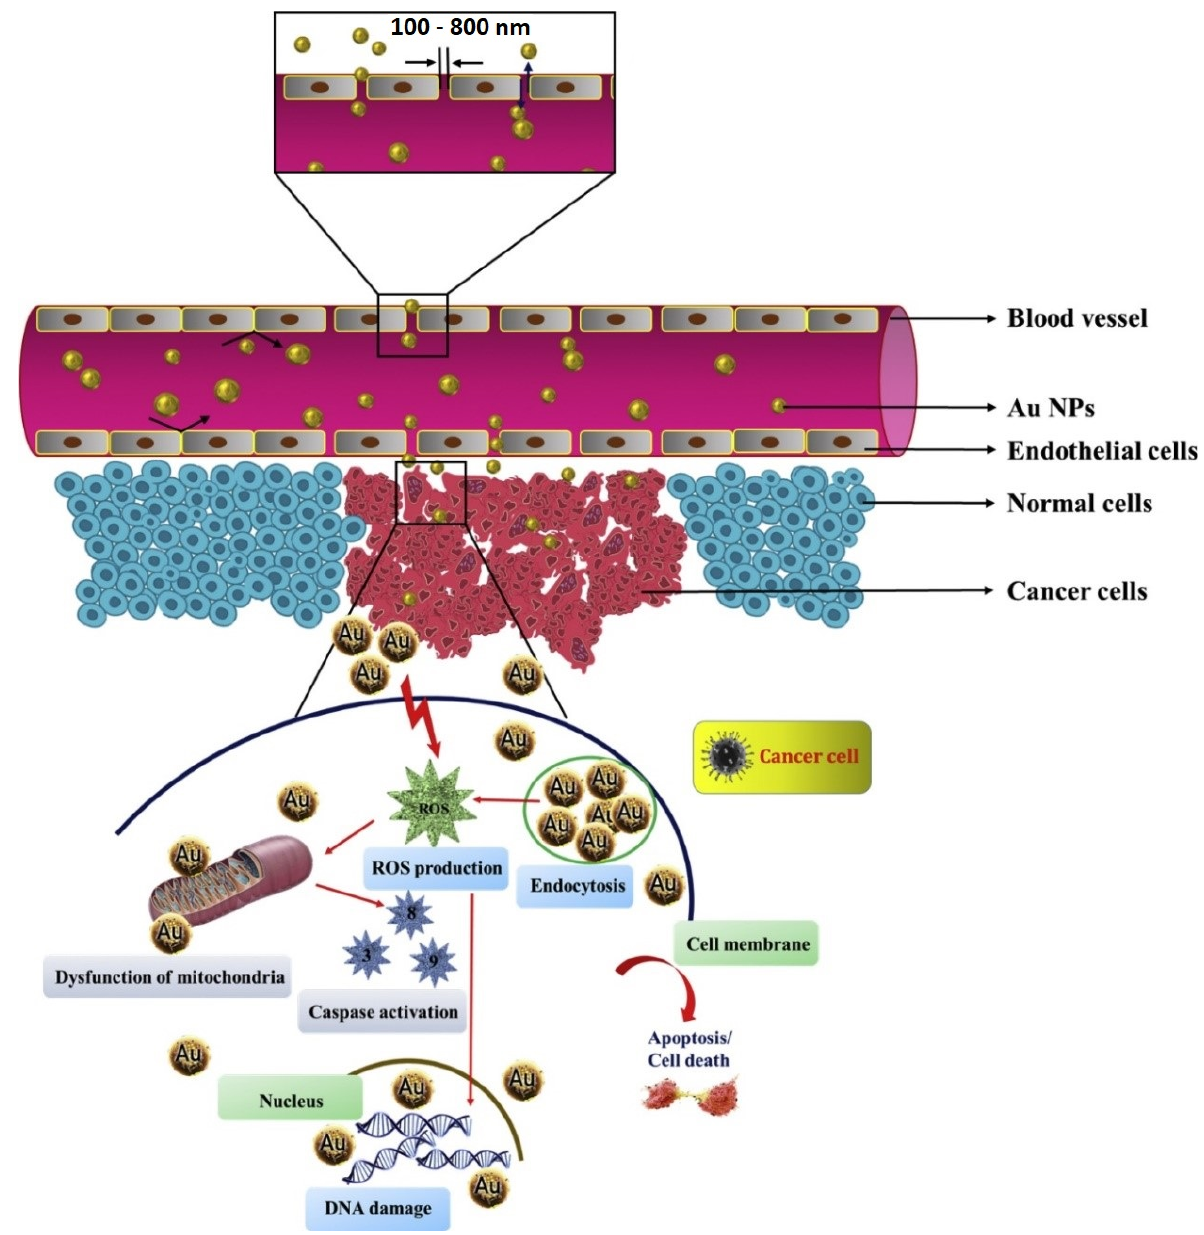
Figure 7. Suggested anticancer mechanisms of AuNPs. Reproduced with permission from [141], Elsevier, 2021.